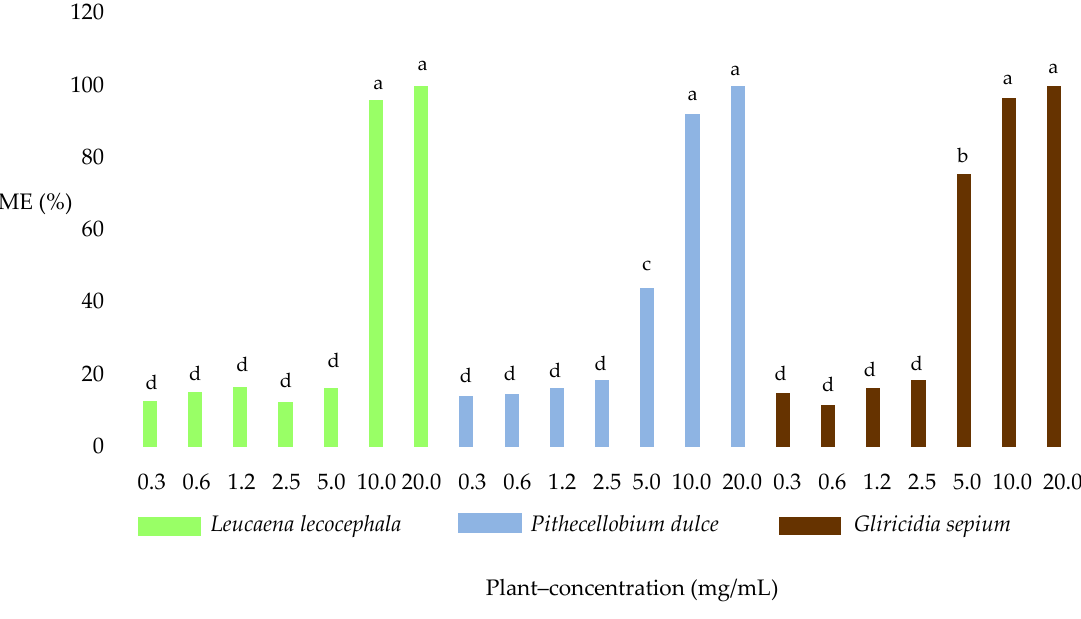
Figure 3. Plant–concentration effect on the percentage of morulated eggs (ME). Means marked with the same letter are not significantly different ( p > 0.05). Fisher LSD test.